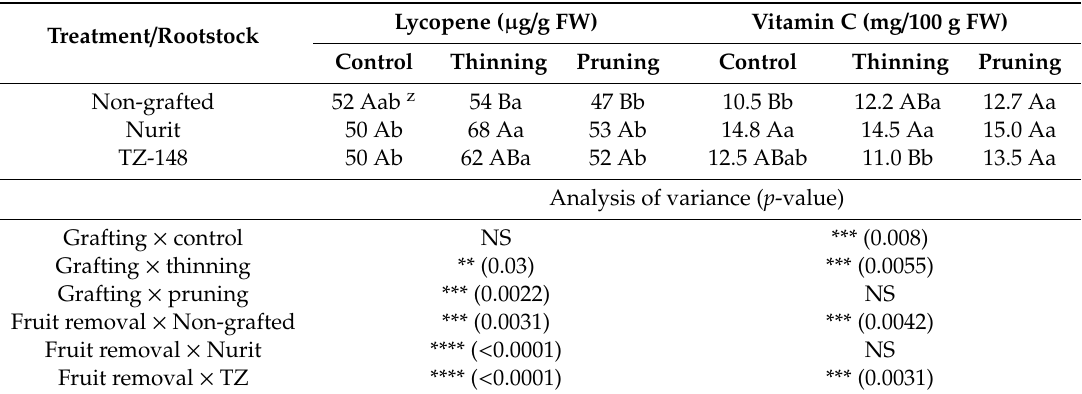
Table 4. E ff ects of rootstock, pruning and thinning on the lycopene and vitamin C content of fruits after 4 days of storage at 22 ◦ C ( n = 16 fruits in two